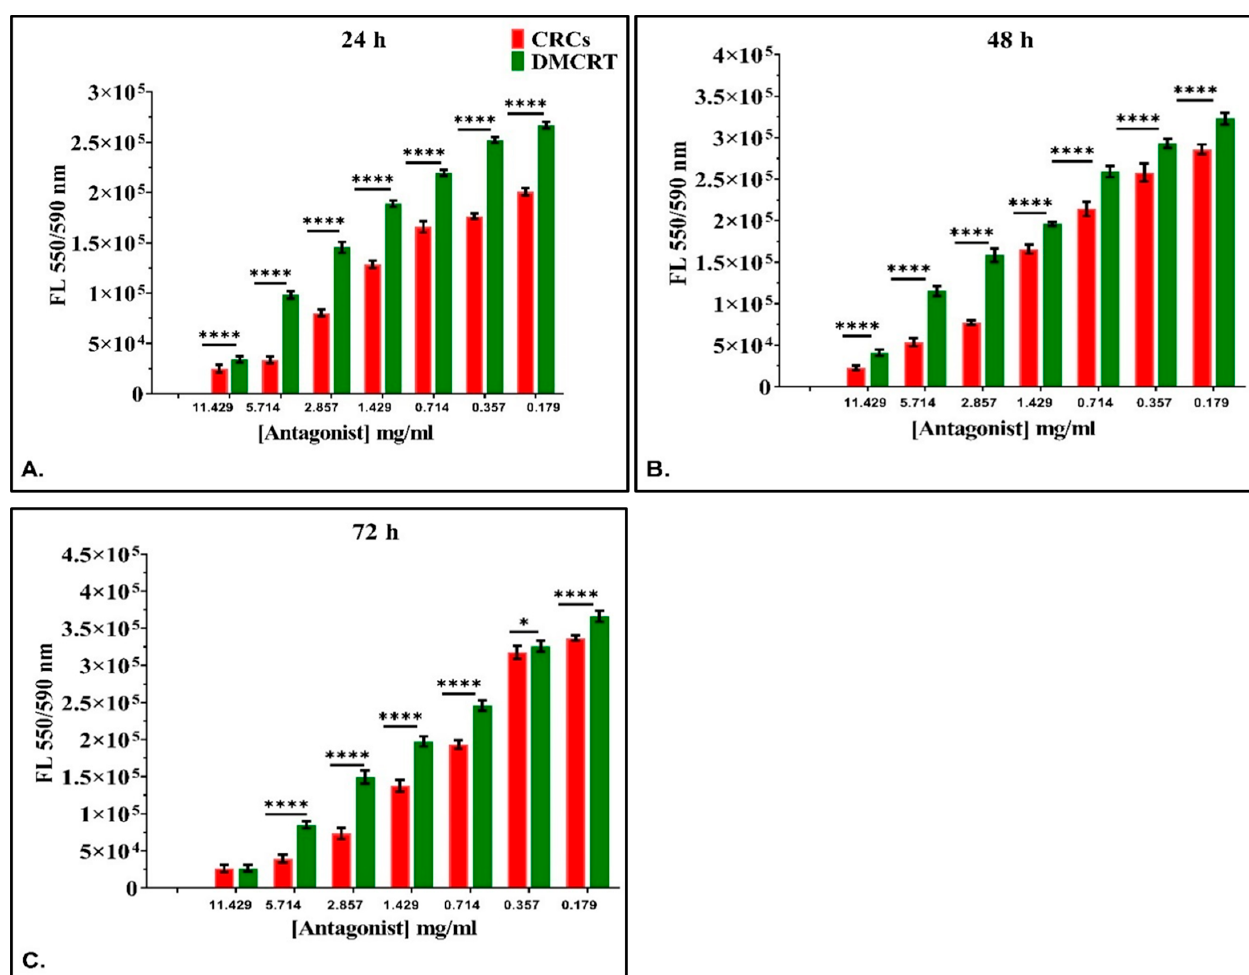
Figure 8 . Comparative dose-dependent effect of CRCs and DMCRT on TE671 cells. The comparative effectiveness of CRCs and DMCRT, was investigated and presented together. CRCs and DMCRT